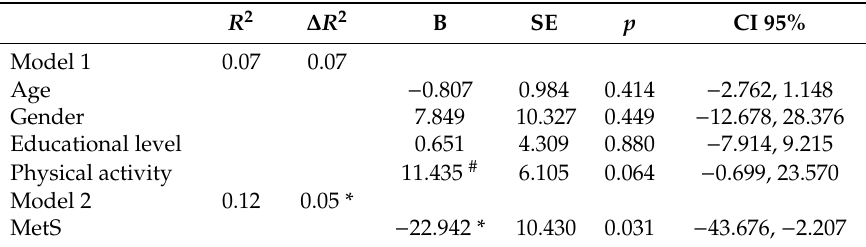
Table 6. Relationship between MetS and subjective-physical